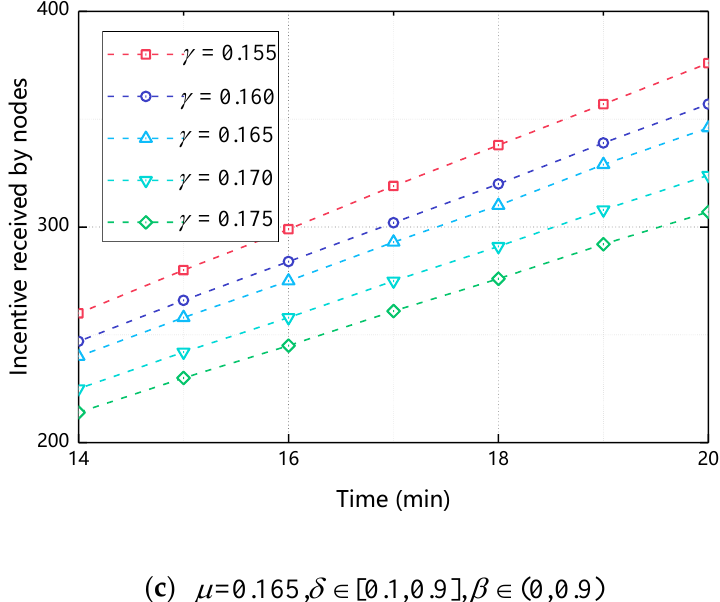
Figure 7. The impact of γ on incentive received by nodes.